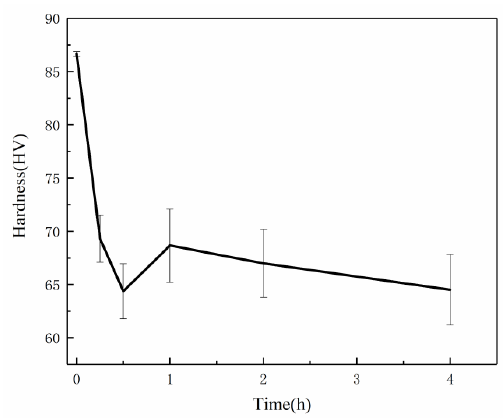
Figure 5. Vickers hardness of the annealed Al-14.5Si alloys solidified under a super-gravity field.